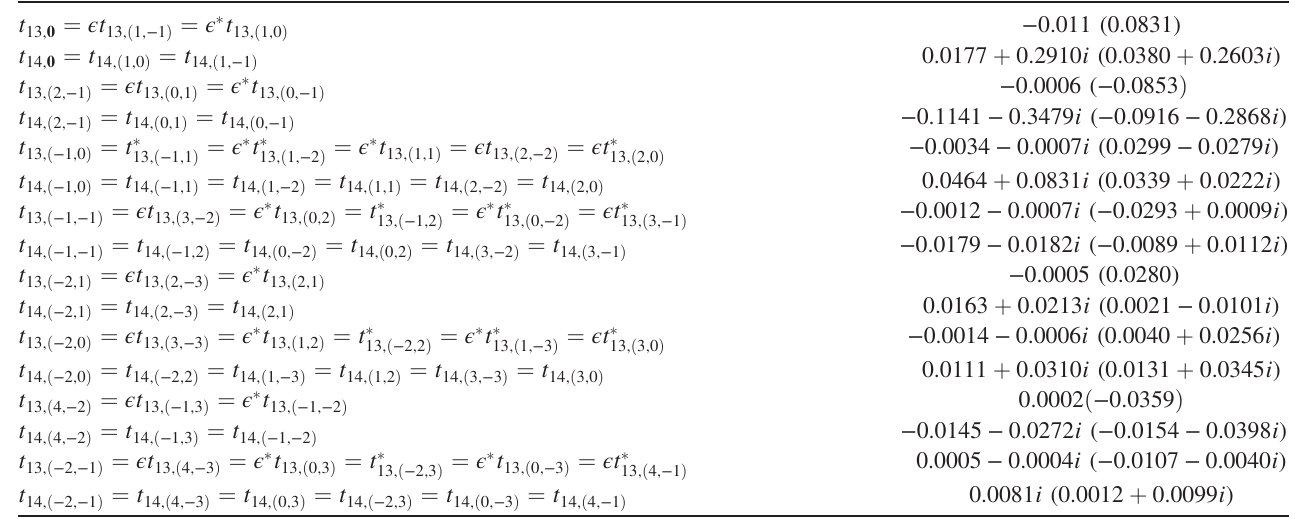
TABLE I. The hopping constants between w 1 projection method ( WANNIER 90 ). All the numbers are in units of milli-electron